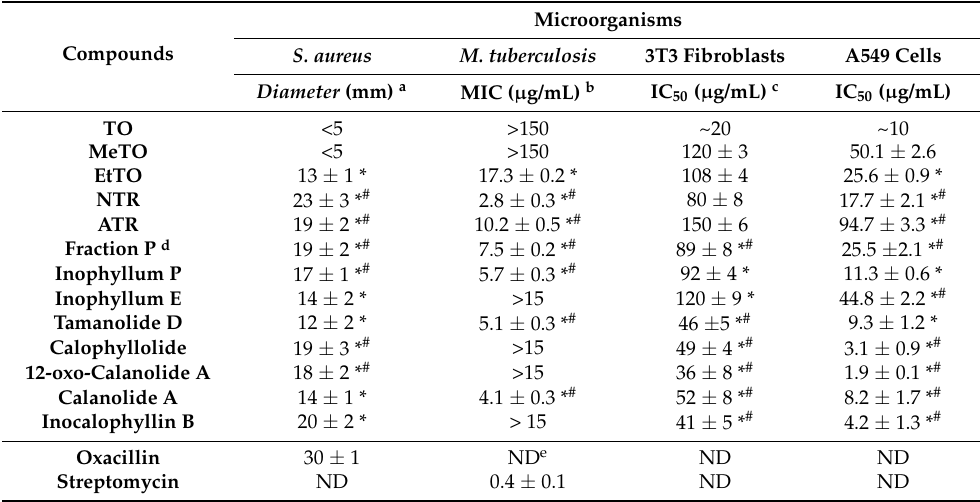
Table 3. Antimicrobial ( S. aureus ) and antimycobacterial ( M. tuberculosis H37 RV) activities and cytotoxicity on murine 3T3 fibroblasts and human lung carcinoma cells A549 of Tamanu oil (TO) extracts, subfractions and selected